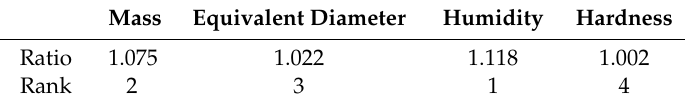
Table 2. Sensitivity analysis of the model RBF